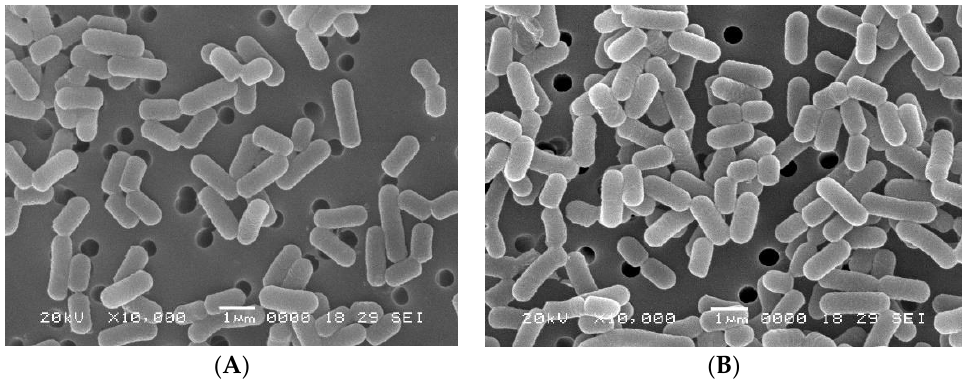
Figure 1. Morphology of L. plantarum KCC-37 and L. plantarum KCC-38. Morphological characteristic were captured by the SEM image system at 10,000 × magnification. ( A ) L. plantarum KCC-37; ( B ) L. plantarum KCC -38.